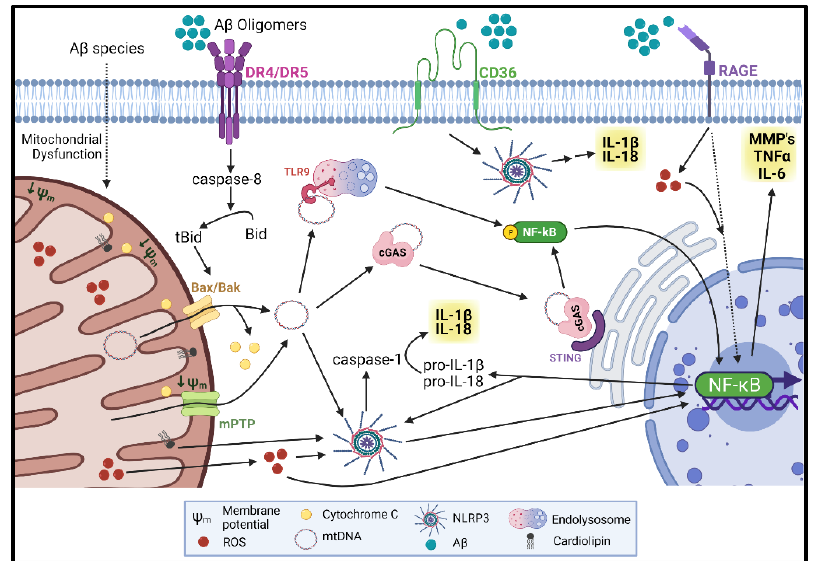
Figure 1. A β induces the release of mitochondrial DAMPs in cerebral endothelial cells (ECs) inducing vascular activation. Mitochondrial dysfunction is induced by A β , at least in part, through the binding and activation of TRAIL Death Receptors (DRs) and activation of the extrinsic and intrinsic apoptotic pathway. Amyloid β has been shown to induce loss of mitochondrial membrane potential ( Ψ m), increase in the generation of mitochondrial reactive oxygen species (mtROS), and permeabilization of mitochondrial membranes leading to the release of cytochrome C and mitochondrial DNA (mtDNA) into the cytoplasm of endothelial cells. The increase of mtROS leads to the activation of the NLRP3 inflammasome, activation of caspase-1 and NF κ B, resulting in the release of IL-1 β and IL-18. Perme- abilization of the inner mitochondrial membrane (IMM) and outer mitochondrial membrane (OMM) lead to the release of mtDNA to the cytoplasm. The presence of double stranded DNA (dsDNA) activates the NLRP3 inflammasome, toll-like receptor 9 (TLR9) on the endolysosomal compartment, and the cGAS/STING pathway on the cytosol and endoplasmic reticulum (ER) membrane, which lead to the activation of NF κ B and upregulation of more pro-inflammatory cytokines. Amyloid β can also activate the NLRP3 inflammasome by binding to the CD36 membrane receptor, or increase the production of ROS through the RAGE receptor. The exponential increase in pro-inflammatory cytokines leads to blood–brain barrier (BBB) disruption, through activation of matrix metallopro- teinases (MMPs), downregulation of tight junction (TJ) proteins, EC activation, and expression of cell adhesion molecules. Figure created with